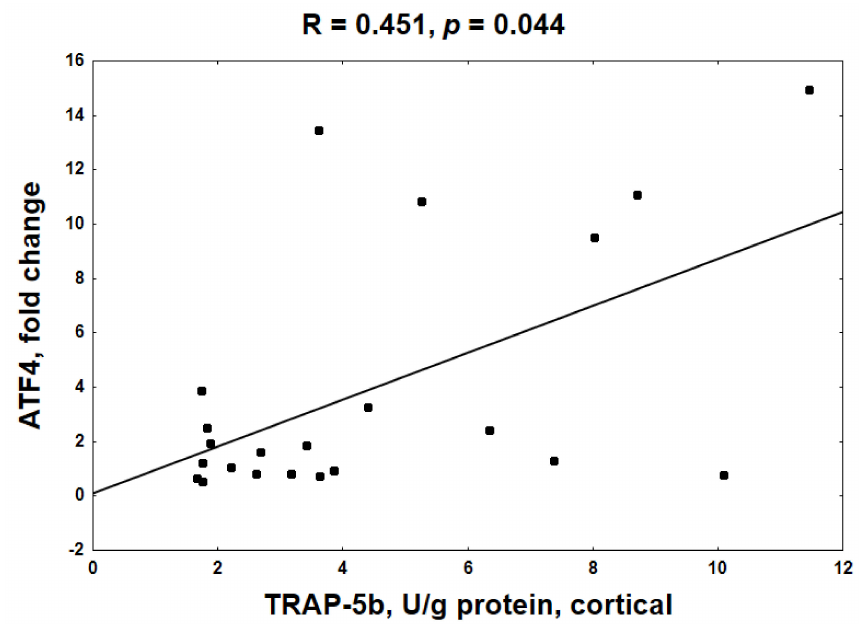
Figure 6. The relationship between the activating transcription factor 4 (ATF4) gene expression and tartrate-resistant acid phosphatase 5b (TRAP-5b) activity at cortical bone